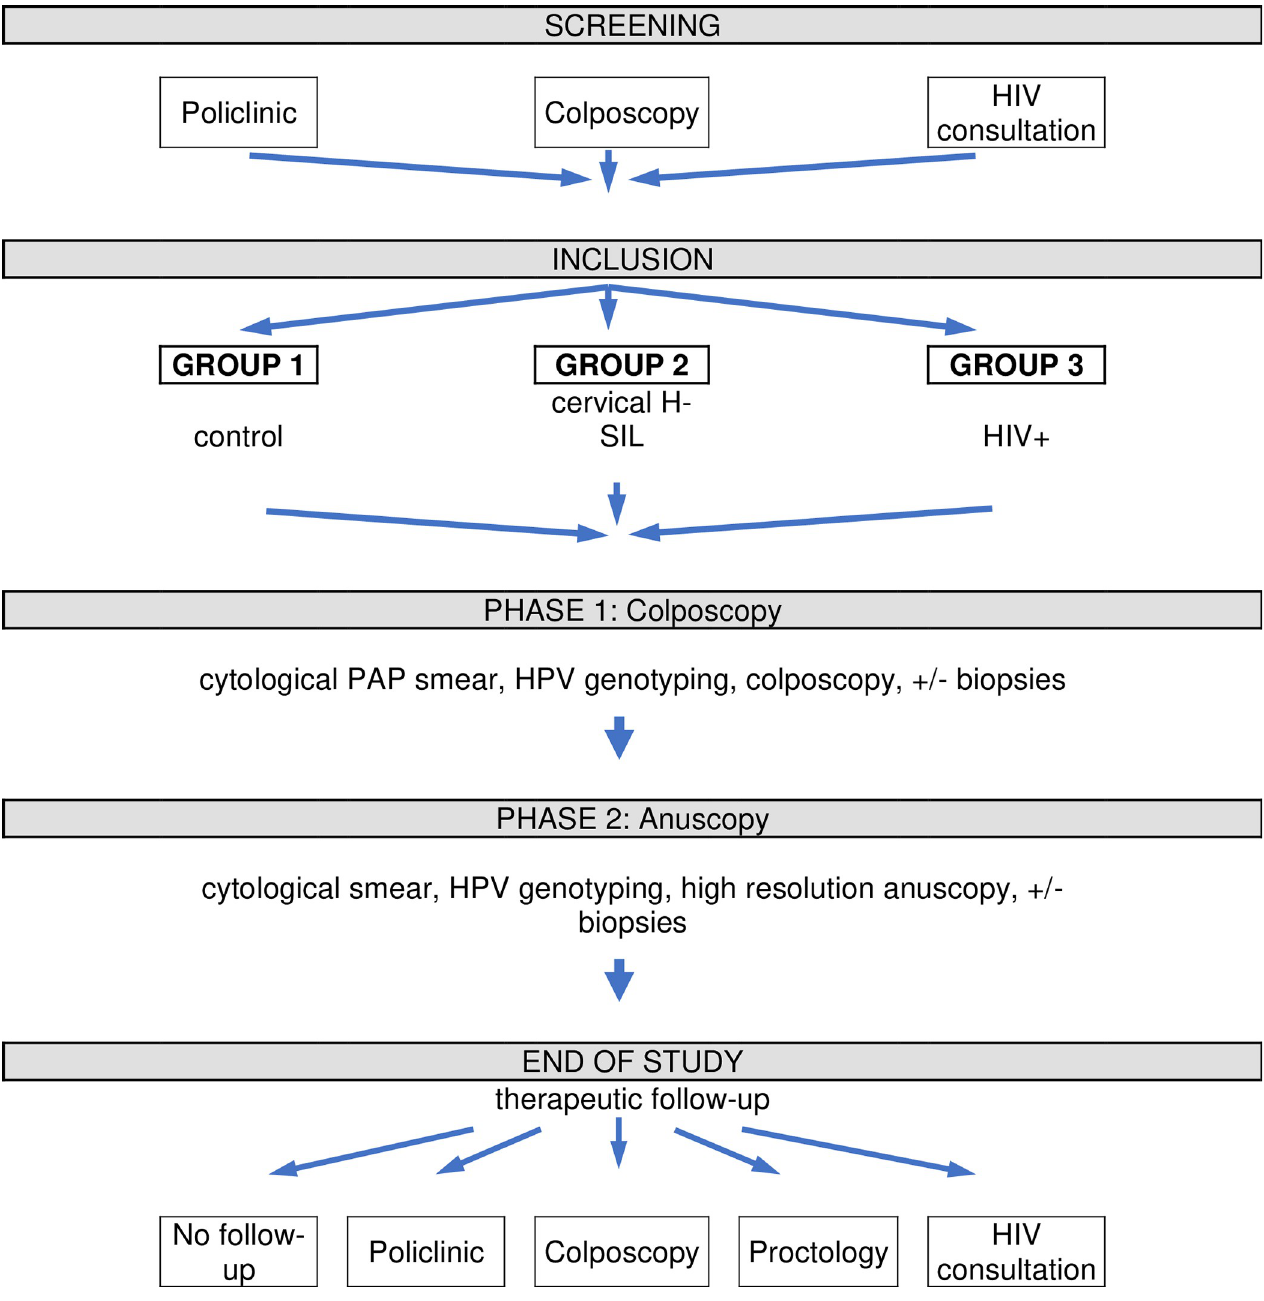
Fig 1. Flow chart of study